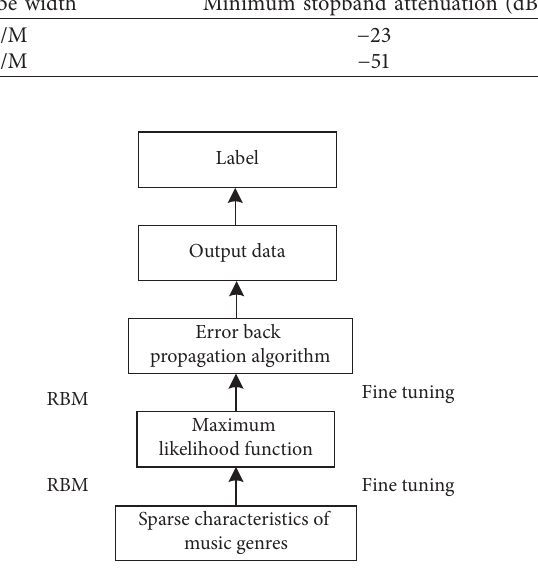
Figure 5: Structure diagram of music genre classification network